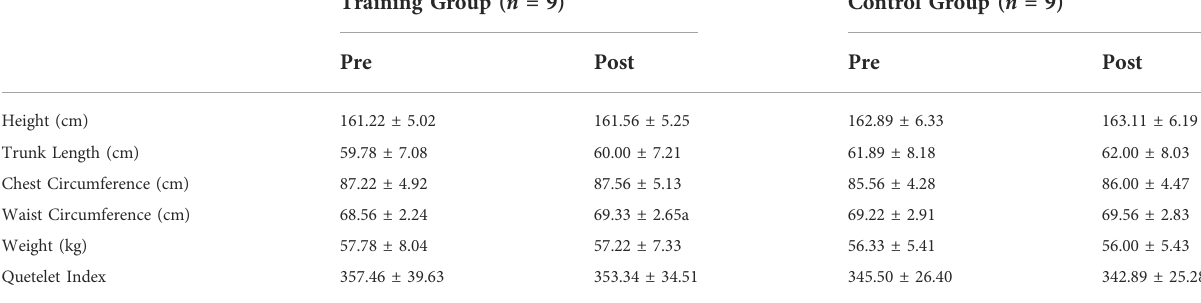
TABLE 2 Body shape results (Mean ±